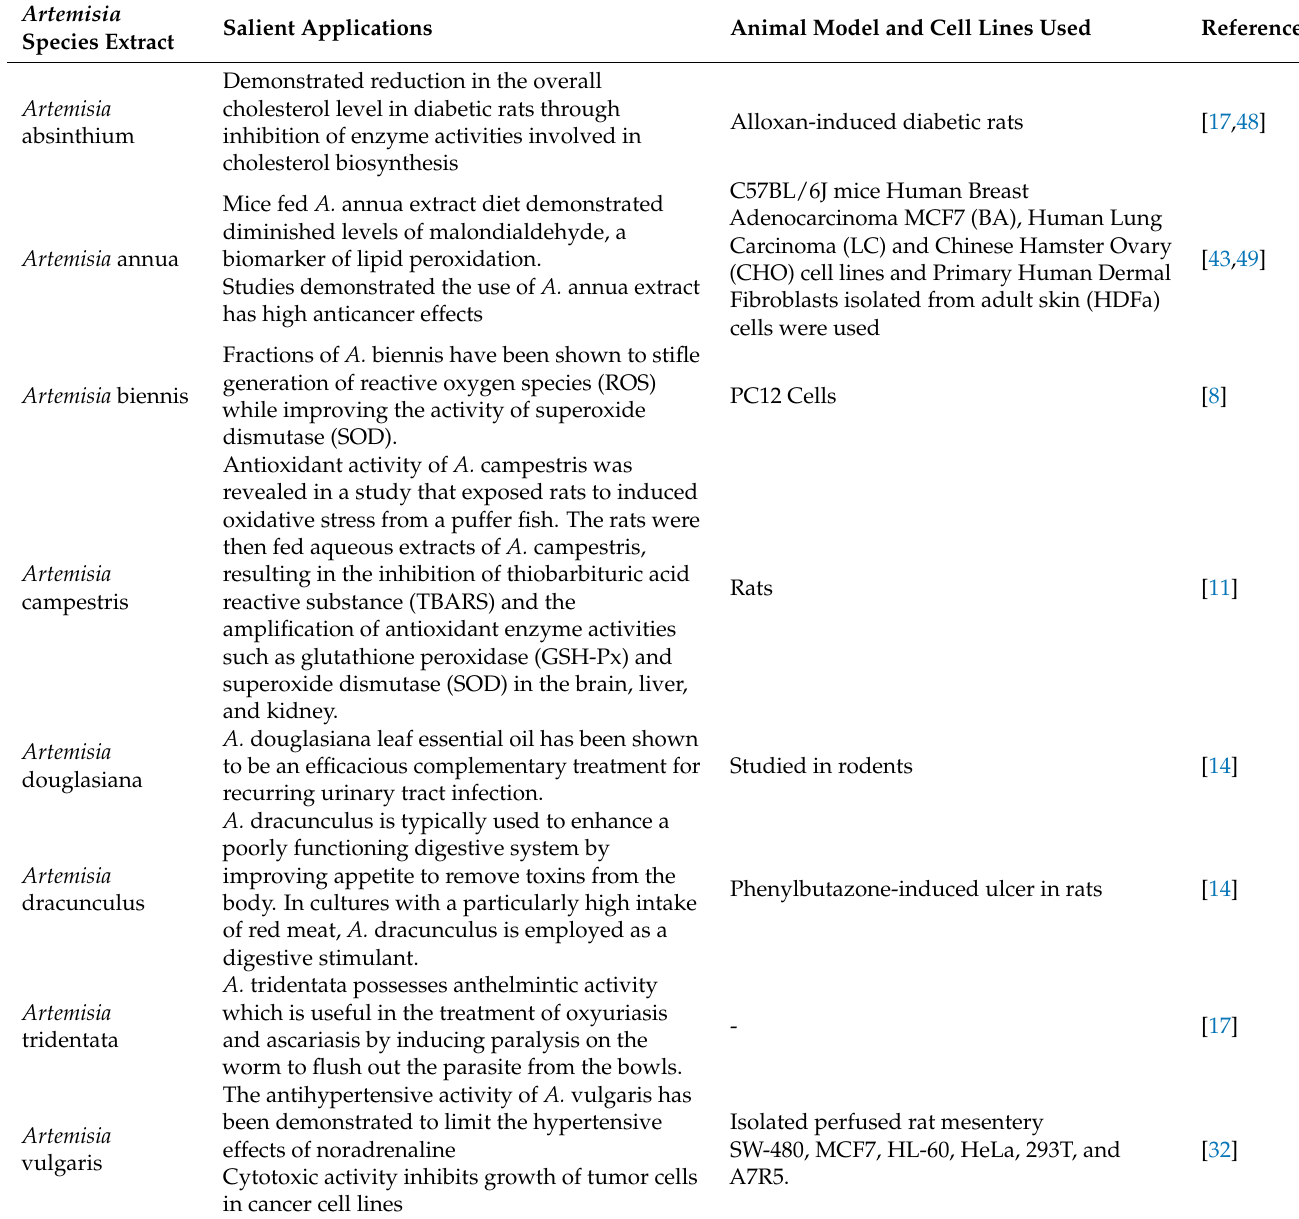
Table 2. Health bolstering effects of Artemisia